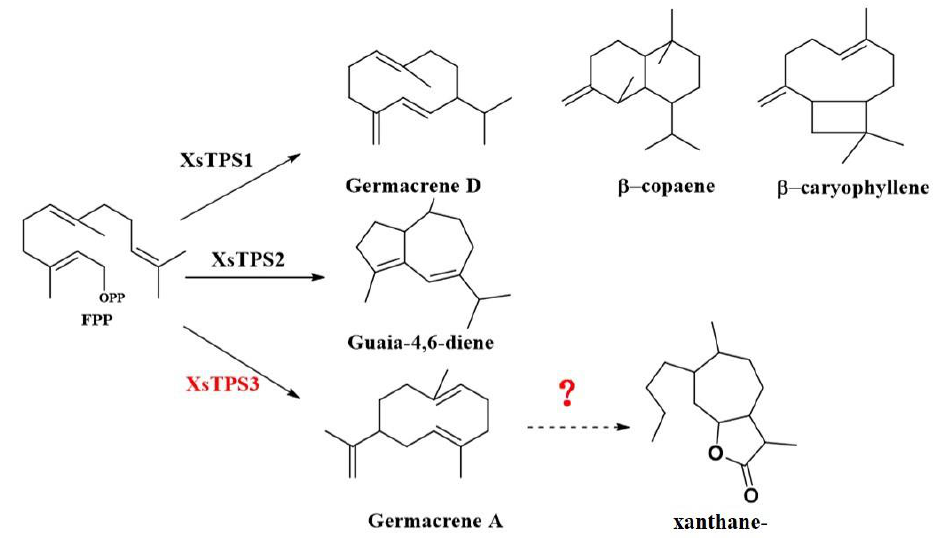
Figure 1. Overview of STL synthesis in X. stramonium . Solid lines are actual biosynthetic steps, and the dashed line indicates the hypothesized synthetic step.